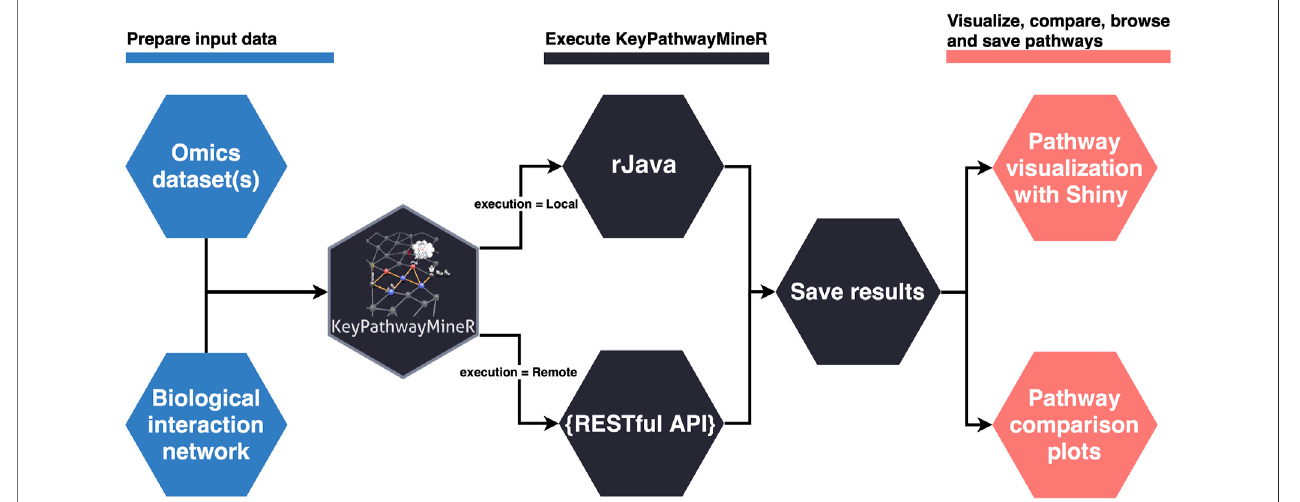
FIGURE 1 | Typical work fl ow of